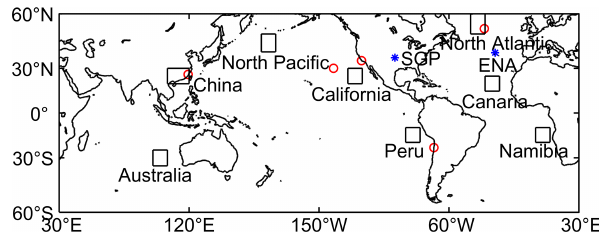
Figure 7. Blue asterisk marks the SGP and ENA sites. Red cy- cles mark the locations of radiosonde stations from the IGRA. Eight 10 ◦ × 10 ◦ boxes are the most typical low-cloud-dominated regions defined in Klein and Hartmann